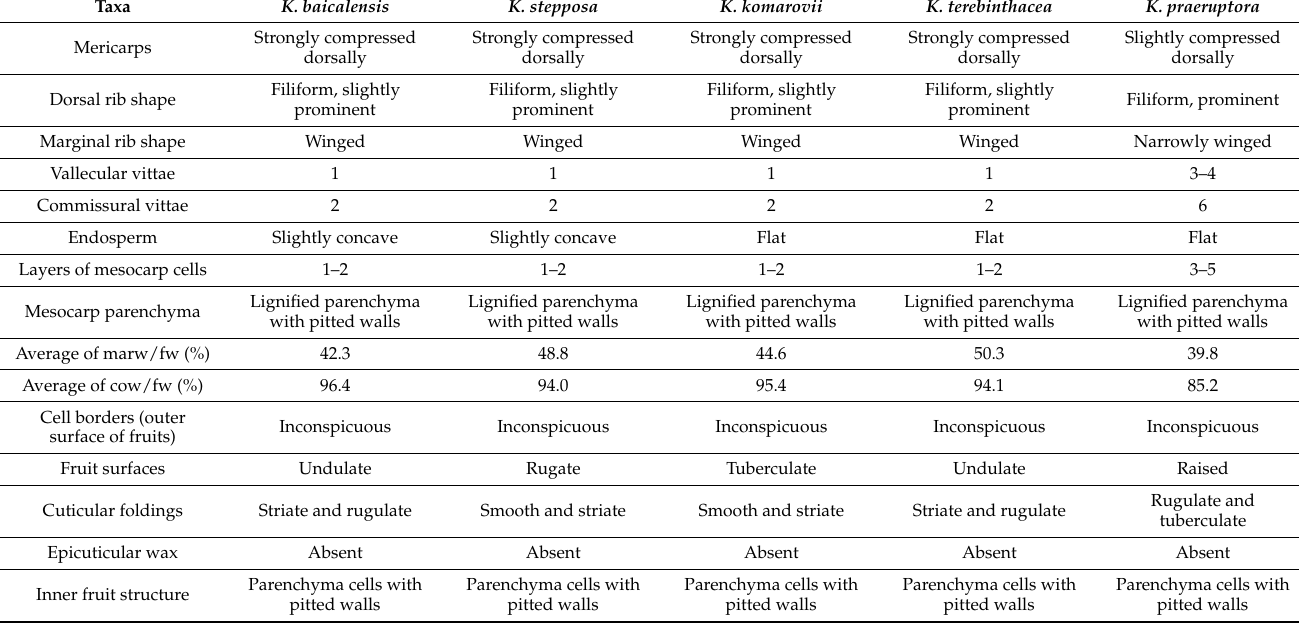
Table 2. Fruit anatomical and micromorphological characteristics of five Kitagawia